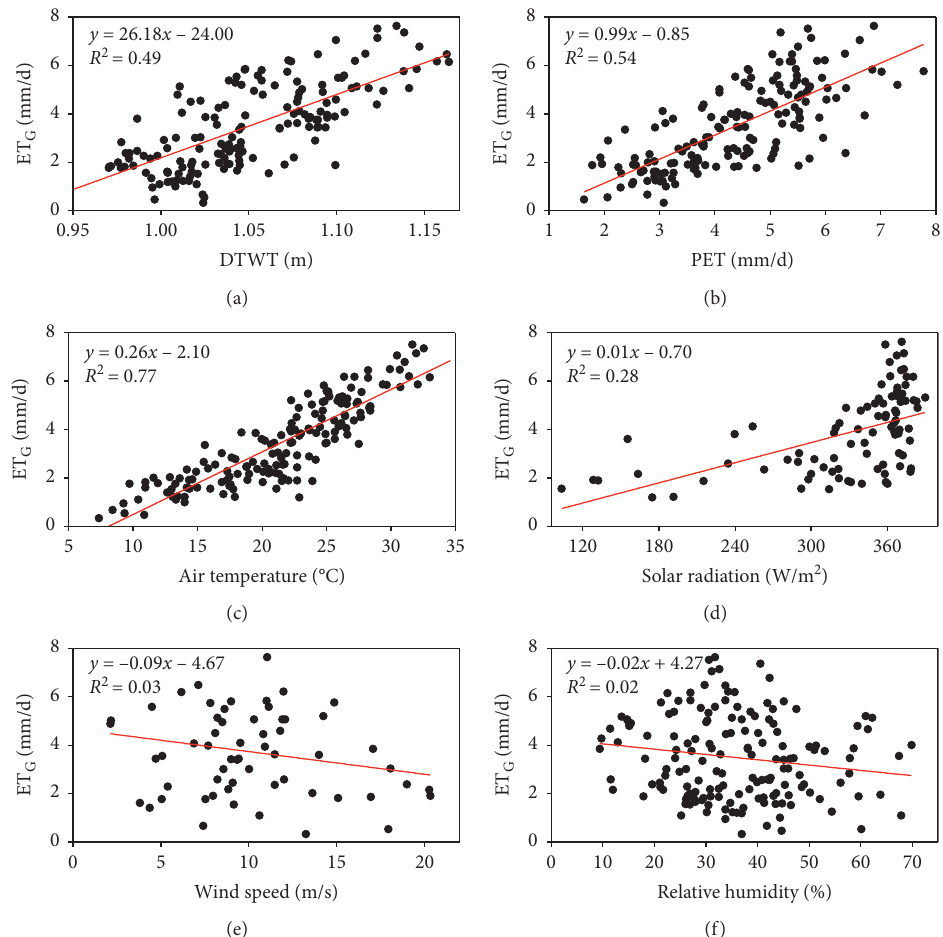
Figure 6: Relationship of diurnal groundwater level fluctuations with depth to water table (DTWT), potential evapotranspiration (PET), air temperature, solar radiation, wind speed, and relative humidity at observation site